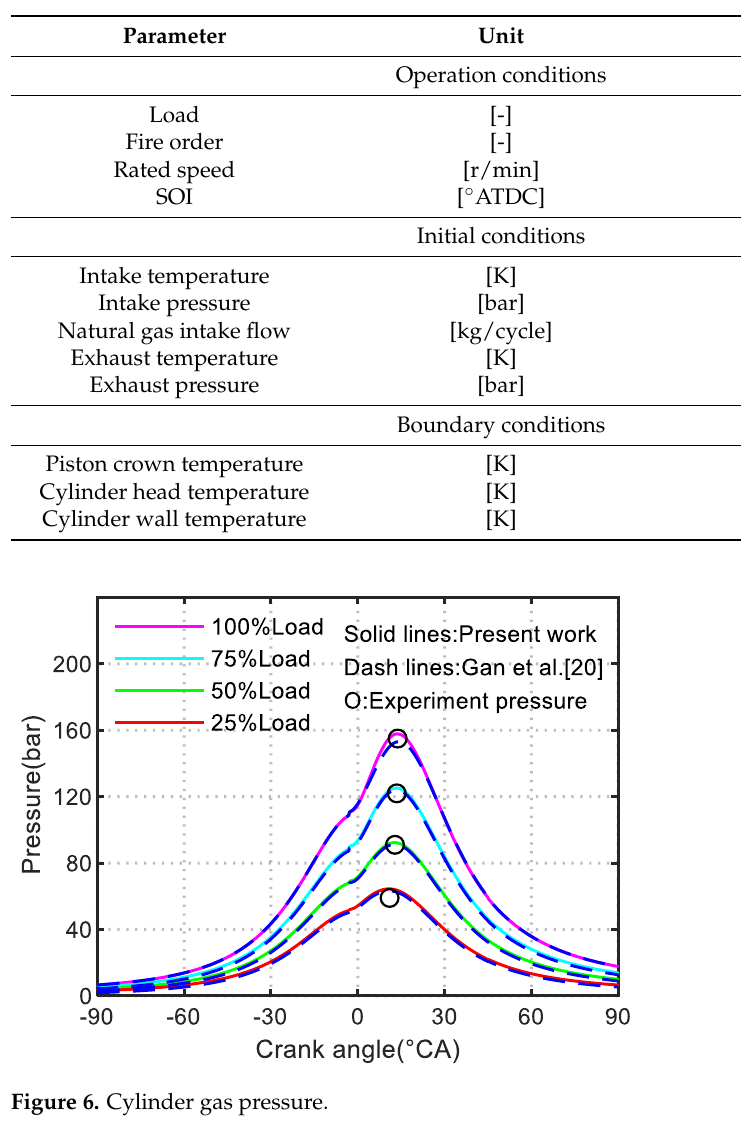
Figure 7. Max.Firing.Pressure comparison between simulation and experiment. Figure 8. Power comparison between simulation and experiment.